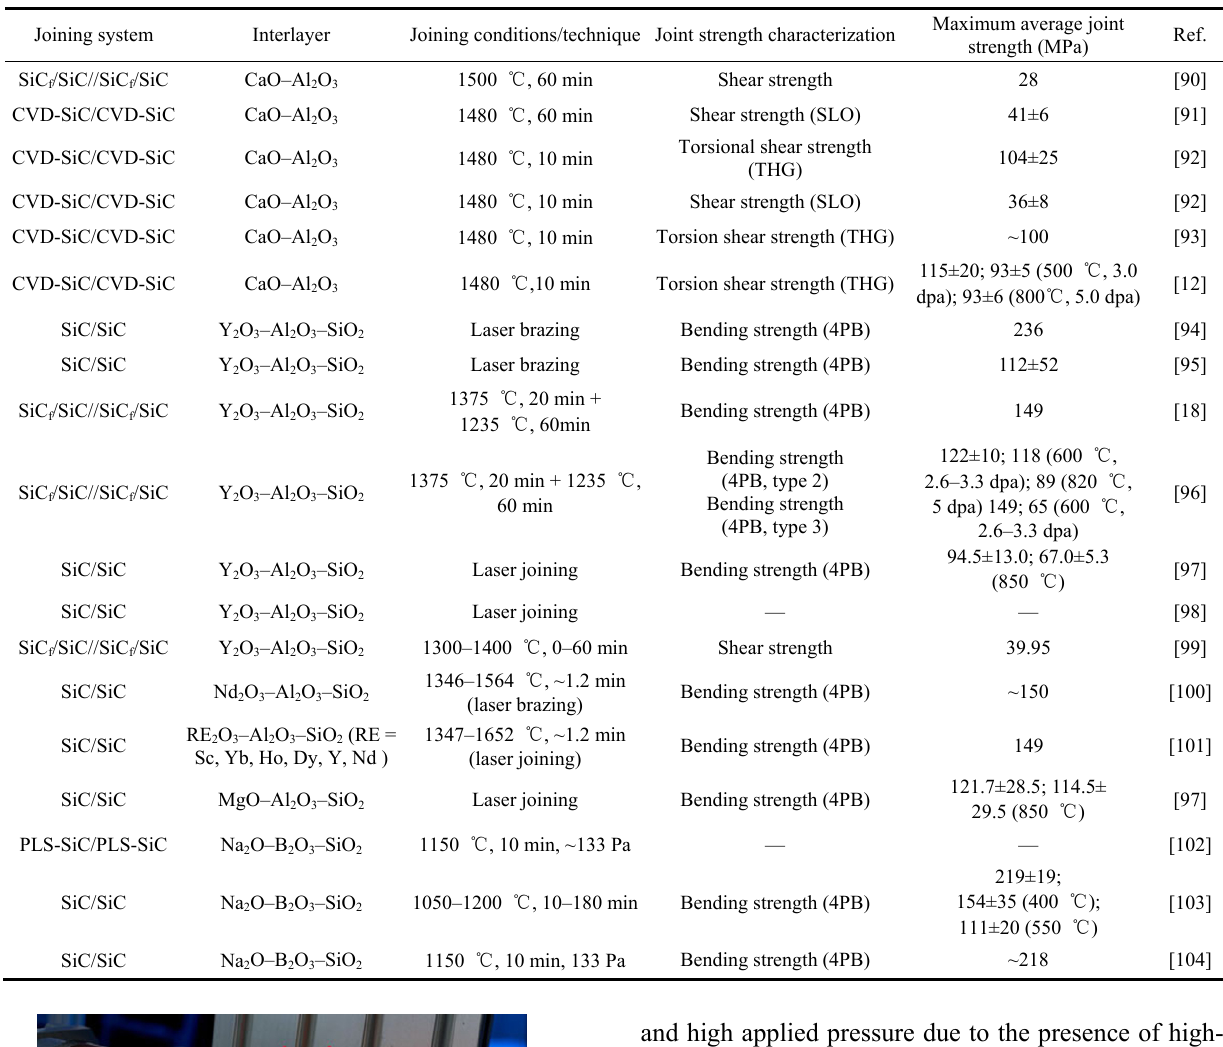
Table 6 Joining of SiC-based materials using glass ceramics as interlayer: interlayer, joining conditions/technique, and joint strength